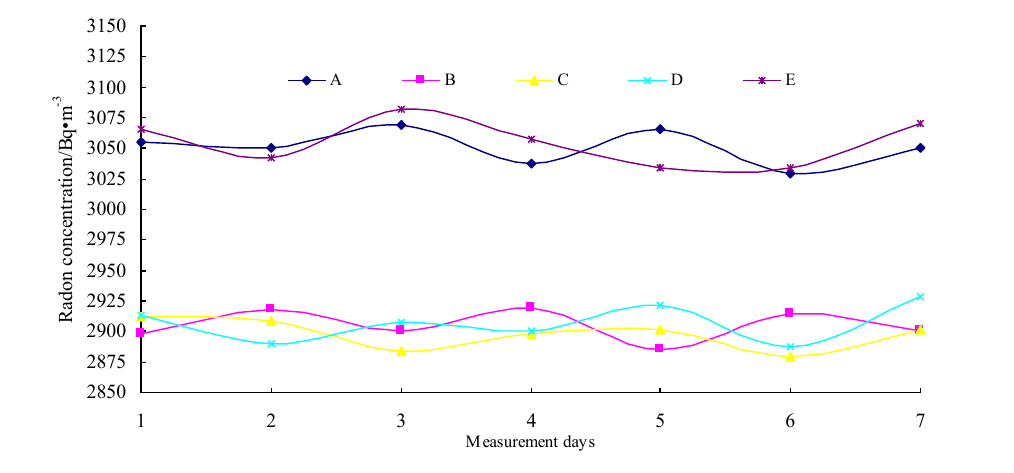
Figure 12. The variations of radon concentration of the EP.